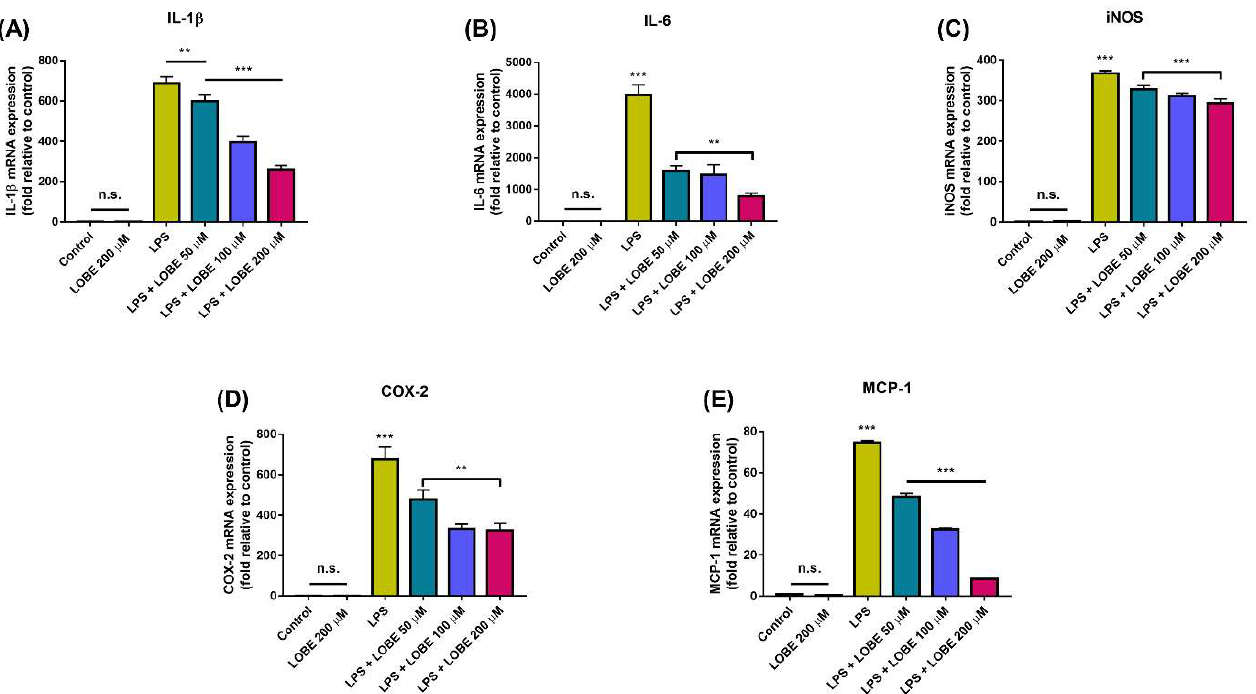
Figure 4. LOBE mediated down-regulation of gene expression of key pro-inflammatory molecules in LPS-induced BMDMs. The BMDMs were pre-treated with or without LOBE for 20 min, and then stimulated or not with 0.1 µg/mL of LPS for 24 h. The cells were then subjected to real-time quantitative polymerase chain reaction (RT-qPCR) analysis to detect mRNA expression levels of proinflammatory mediators ( A ) interleukin-1β (IL-1β) ( B ) IL-6, ( C ) inducible nitric oxide synthase (iNOS), ( D ) cyclooxygenase-2 (COX-2), and ( E ) monocyte chemoattractant protein-1 (MCP-1). The mRNA expressions of target genes were normalized to glyceraldehyde 3-phosphate dehydrogenase (GAPDH) mRNA. The expression level of control for all indicated genes was set at 1-fold, and relative fold change was calculated. Results are the mean ± SD of triplicate experiments: n.s., ** p < 0.01, *** p < 0.001, significant difference as compared to the control group and each group by a one-way ANOVA followed by Tukey’s post hoc analysis.